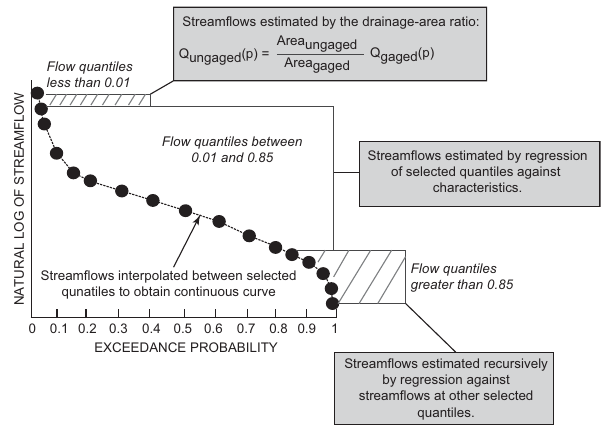
Fig. 2. Diagram showing the methods used to estimate a continuous, daily flow duration at an ungauged